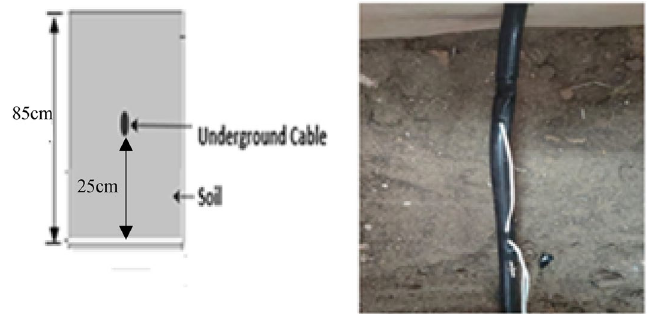
Fig. 5 Schematic design of laying cable direct in